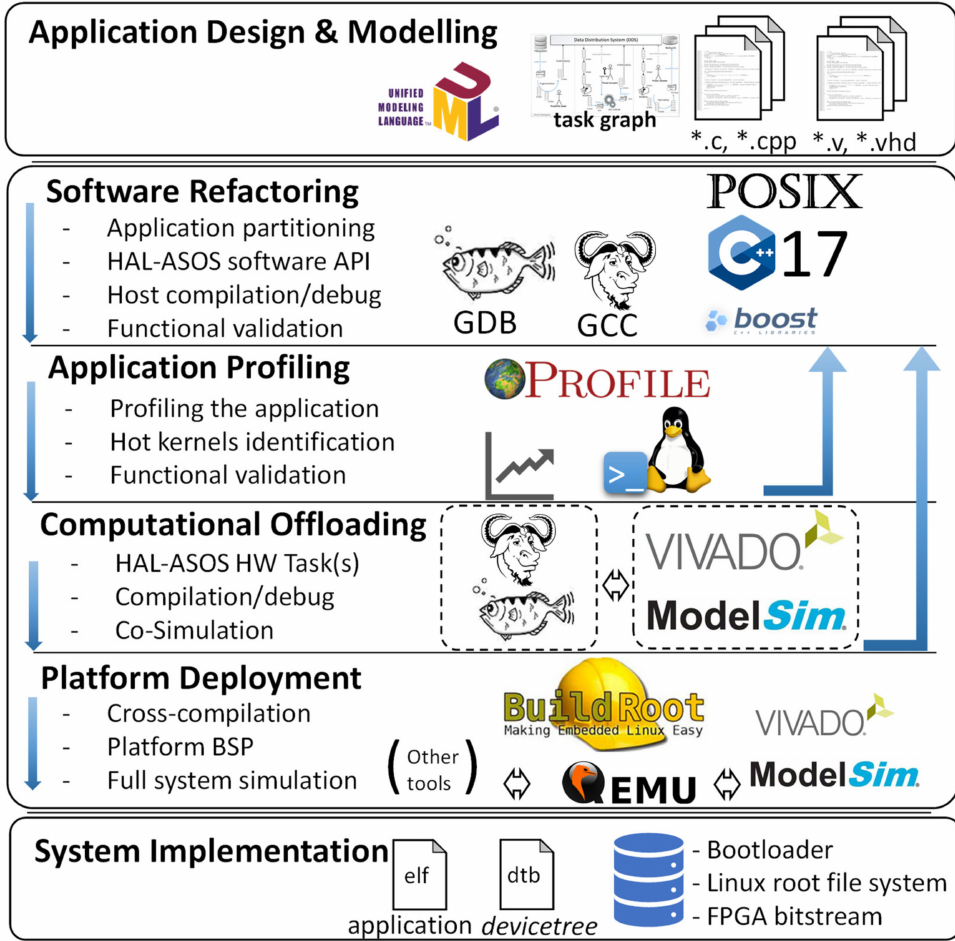
Figure 1. The HAL-ASOS accelerator model design